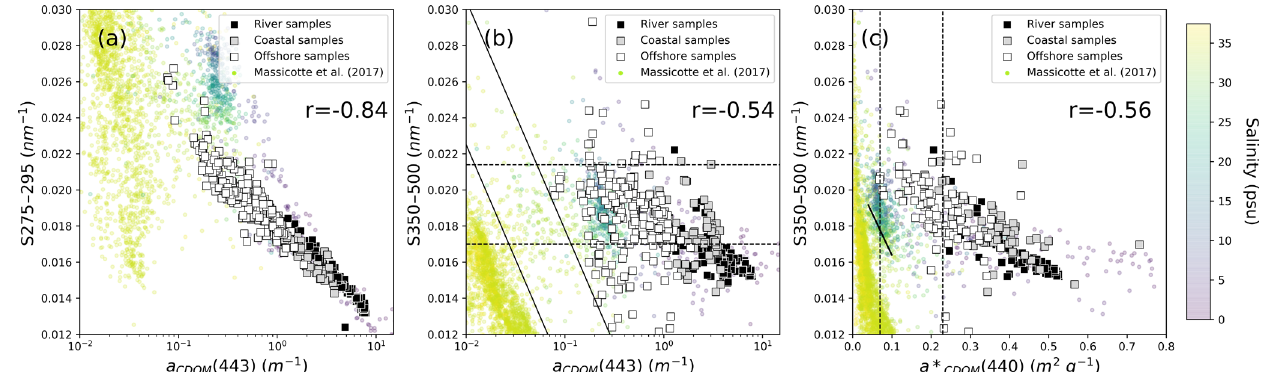
Figure 4. (a) Relationship between a CDOM (443) and S275–295; (b) a CDOM (443) vs. S350–500 with 95% confidence intervals of regressions of western Arctic coastal waters (dashed lines) and for western Arctic oceanic water (solid lines) reported by Matsuoka et al. (2011, 2012), (c) a * CDOM (440) vs. S350–500 with dashed lines representing the borders of a * CDOM (440) for oceanic waters reported by Nelson and Siegel (2002), and the solid line shows the reported relationship between a ∗ (440) and S350–500 from Matsuoka et al. (2012). Circles CDOM show global data from Massicotte et al. (2017) where colours indicate the salinity.